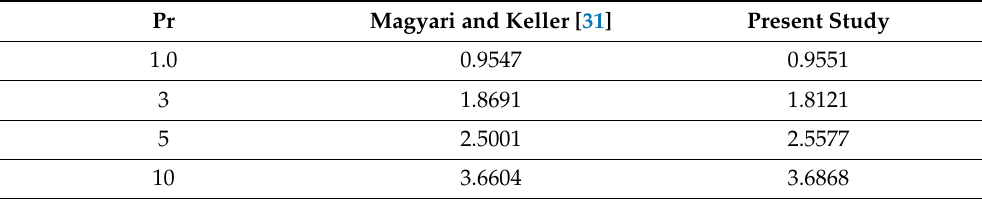
Table 1. Comparison of the − θ (cid:48) ( 0 ) values for several values of Prandtl number for Newtonian fluid